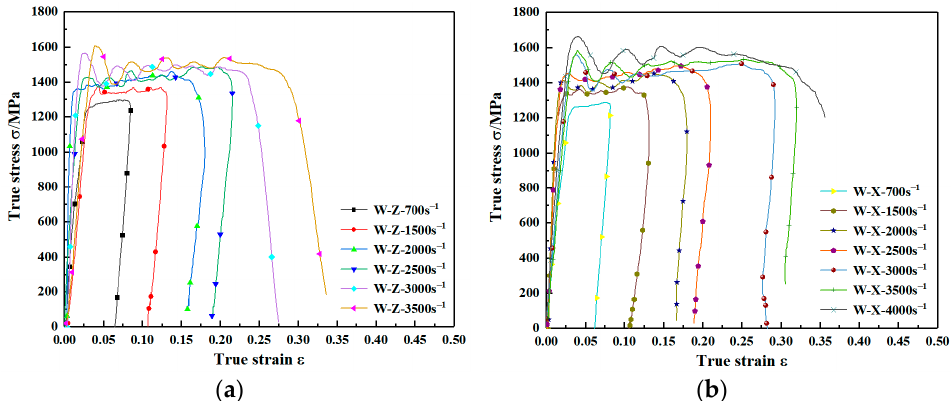
Figure 11. Dynamic stress–strain curve for WAAM TC11 titanium alloy. ( a ) Group Z specimens (deposition direction). ( b ) Group X specimens (scanning direction). Table 2. Yield strength and flow stress of materials at different strain